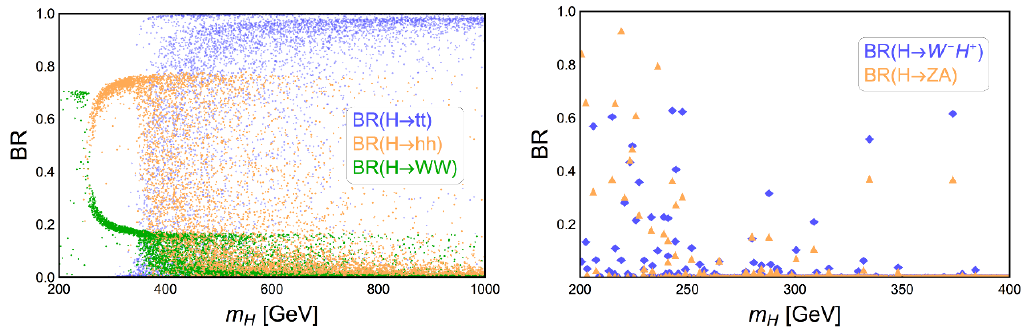
Figure 13 . Correlation between (cid:16) t and (cid:21) Hhh (left) and between sin (cid:18) and (cid:21) Hhh (right).